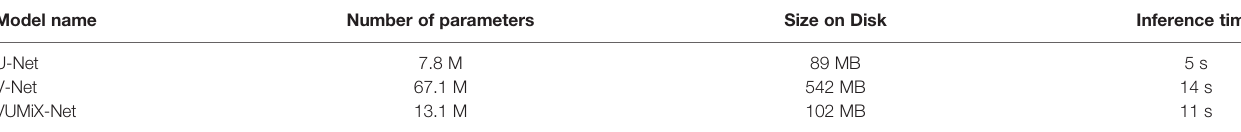
TABLE 7 | Comparison of computational